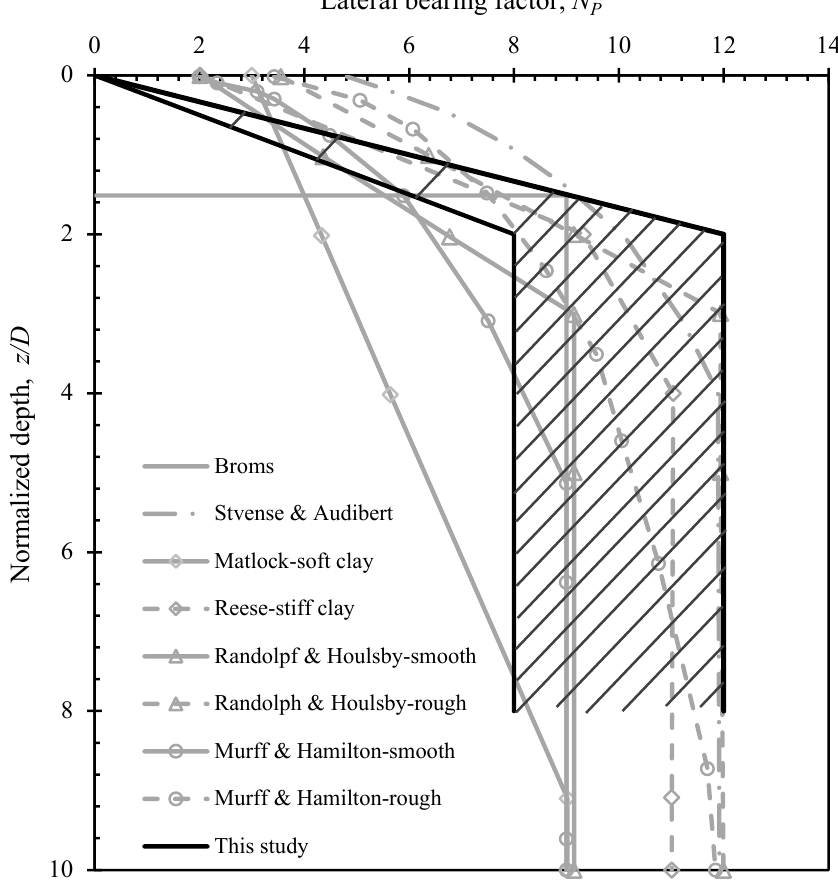
Figure 3. V ariation of lateral bearing factor Np with normalized depth [7,8,35–38]. Figure 3. Variation of lateral bearing factor Np with normalized depth